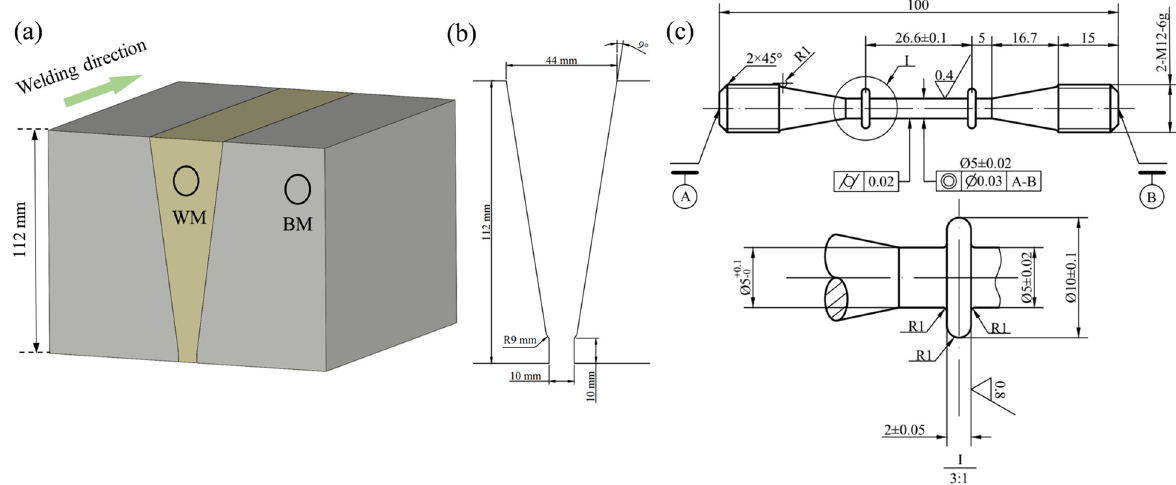
Figure 1: Schematics for ( a ) extracting creep samples from the 2.25Cr1Mo0.25V steel welded joint and ( b ) the groove design; ( c ) dimensions of creep specimen ( unit: mm )